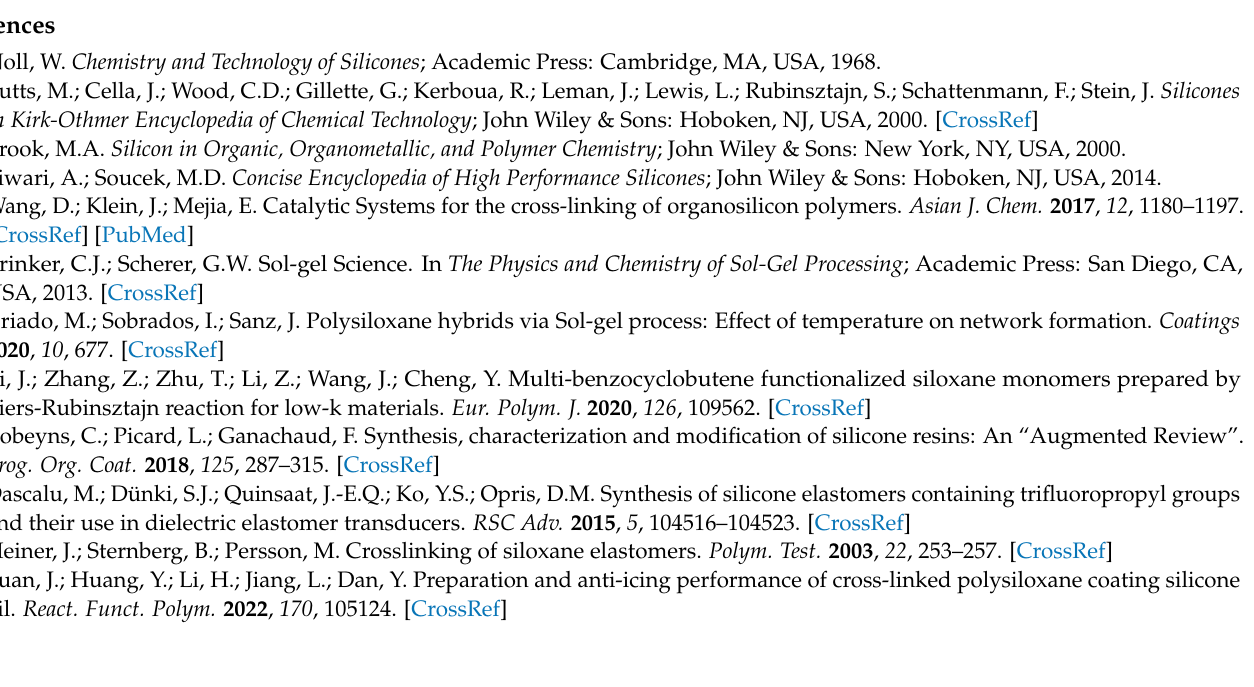
Scattering detector. Figure S5. The 19 F NMR spectra obtained during the reaction of 20 wt% PHMS solution in toluene in the presence of 1 × 10 − 2 mol/L of B(C 6 F 5 ) 3 at 30 ◦ C. Figure S6. (A)—Image of the poor-quality film (Table 3, Film #1); (B)—Image of the good-quality film (Table 3, Film #2). Figure S7. (A)—IR spectra of the solid film #2 held at ambient conditions for 24 h. (B)—SiH conversion vs. time of holding the solid film #2 in ambient conditions and 90 min post-bake at 150 ◦